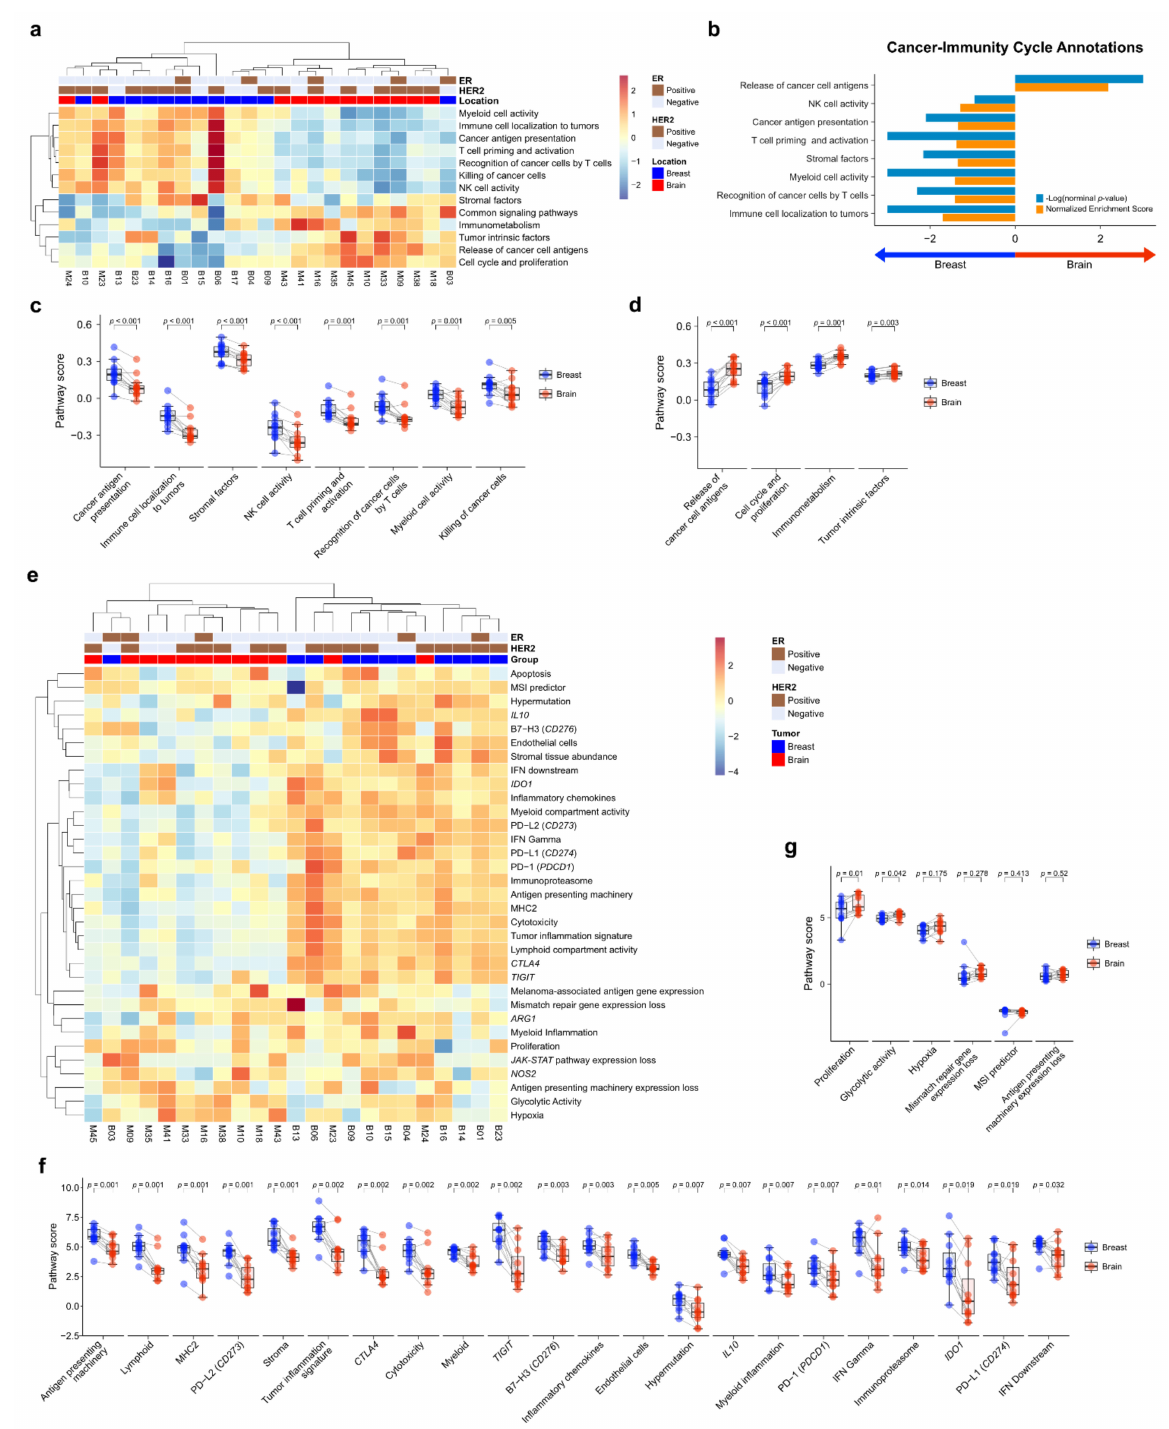
Figure 2. Pathway analysis of primary breast cancer and brain metastasis (BCBM). ( a ) Pathway scores for the cancer- immunity cycle annotation gene set from the nCounter ® PanCancer IO 360™ Panel were calculated with single-sample GSEA (ssGSEA) and visualized as a heatmap. Scores were Z-transformed and displayed on the same scale. ( b ) Gene set enrichment analysis of primary breast cancer versus brain metastasis (BM) visualized using the gene sets for cancer- immunity cycle annotation. ( c , d ) Pairwise box plots of cancer-immunity cycle annotation according to location, showing the sets of pathway scores that were downregulated in BM ( c ) and upregulated in BM ( d ). ( e – g ) PanCancer IO 360 biological signatures calculated using the nSolver analysis program. ( e ) Heatmap of PanCancer IO 360 Biological Signatures revealed that most immune-related scores were downregulated in BM. ( f , g ) Pairwise box plots of PanCancer IO 360 biological signatures according to location showing the sets of pathway scores downregulated in BM ( f ) and upregulated in BM ( g